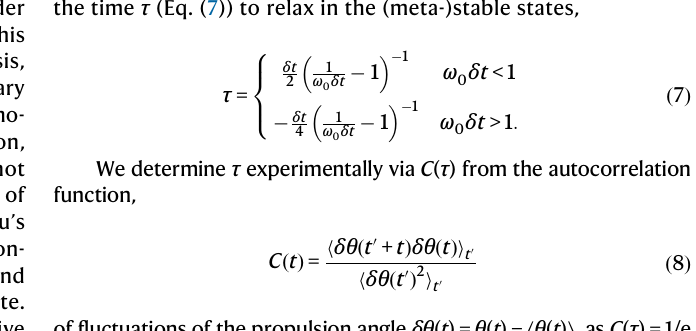
and at δ t = 1.65 s when both shells are co-rotating. The arrows and colors denote the average direction of motion. D Snapshot of the active particles and their propulsion directions corresponding to (C) at δ t = 1.35 s. The repulsion induced by the fl ow and temperature fi elds of the inner shell causes a bias for the outer shell rotation. E Sketch of the fl ow and temperature fi elds induced by the laser (green dot) around an active particle, and the resulting repulsion. F Schematic sketch of the presumed magnitude of the bias caused by the temperature and fl ow fi elds on the rotation of the outer shell, as a function of the propulsion angle θ in of the inner shell particles (see Sec. 5 of Supplementary